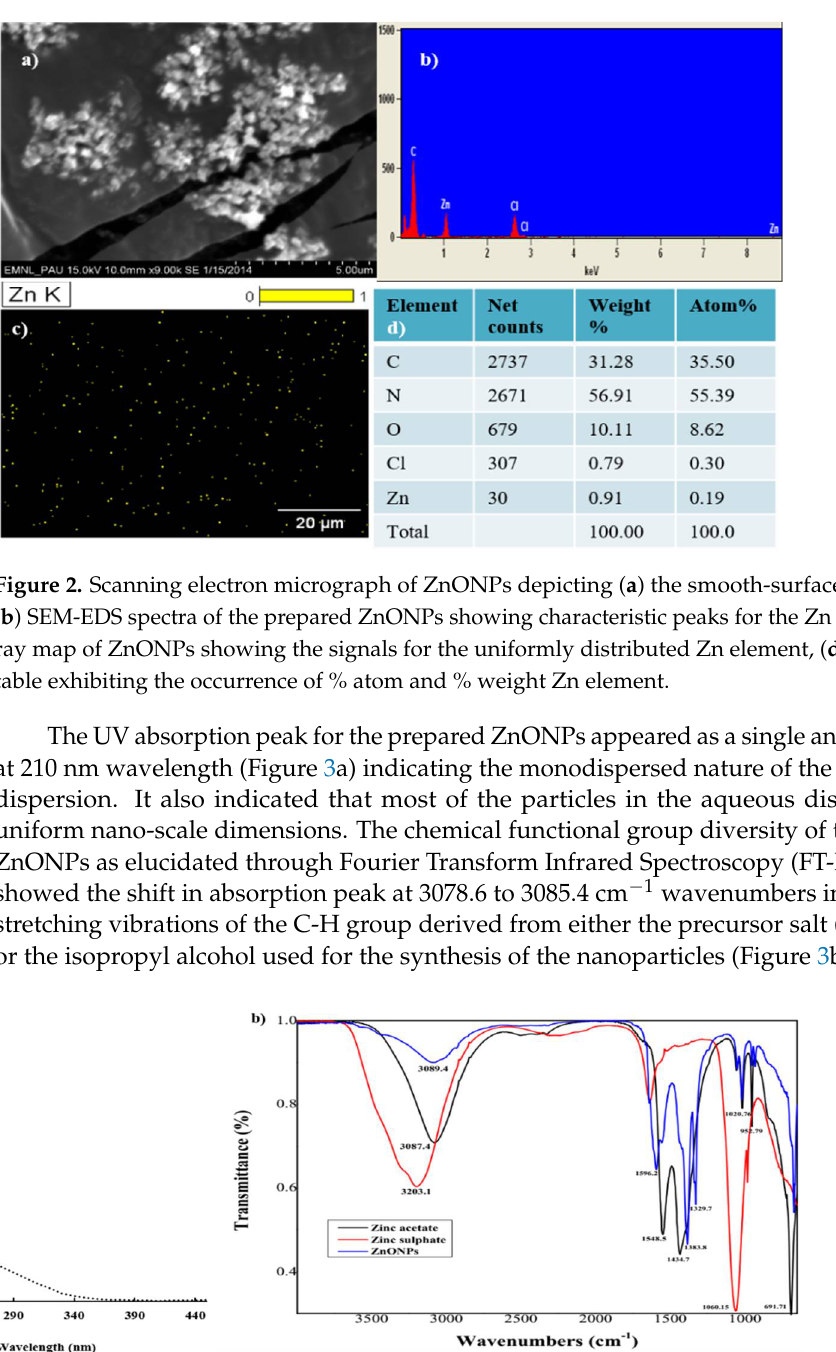
Figure 1. Transmission electron micrographs of zinc oxide nanoparticles showing ( a ) spherical- shaped zinc oxide nanoparticles (ZnONPs), ( b ) size distribution curve.